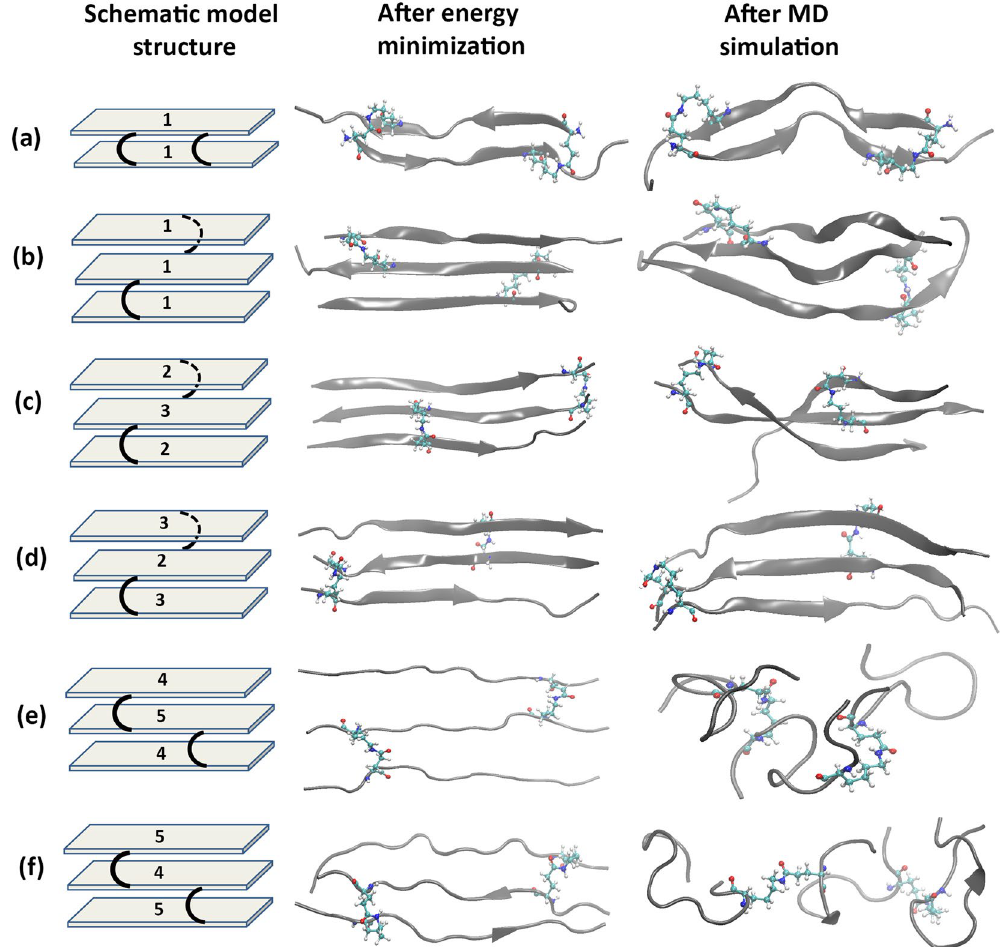
Figure 5. Cross-linked sealant systems: ( a ) sealant1- cis formed as peptide dimer, ( b ) sealant1- trans formed as peptide trimer, ( c ) sealant2- trans type1 formed as peptide trimer (two peptide2 and one peptide3), ( d ) sealant2- trans type2 formed as peptide trimer (two peptide3 and one peptide2), ( e ) sealant3- cis type1 formed as peptide trimer (two peptide4 and one peptide5) and ( f ) sealant3- cis type2 formed as peptide trimer (two peptide5 and one peptide1). The first column shows spatial arrangement of the isopepide cross-linking (black curved lines) and the peptides are simplified as grey bars with assigned peptide number. The second column shows energy minimized structures and the third column shows corresponding structures after MD simulation. The secondary structural elements are shown as cartoon and interacting Lys and Gln pairs forming isopeptide bonds are shown in ball and stick.